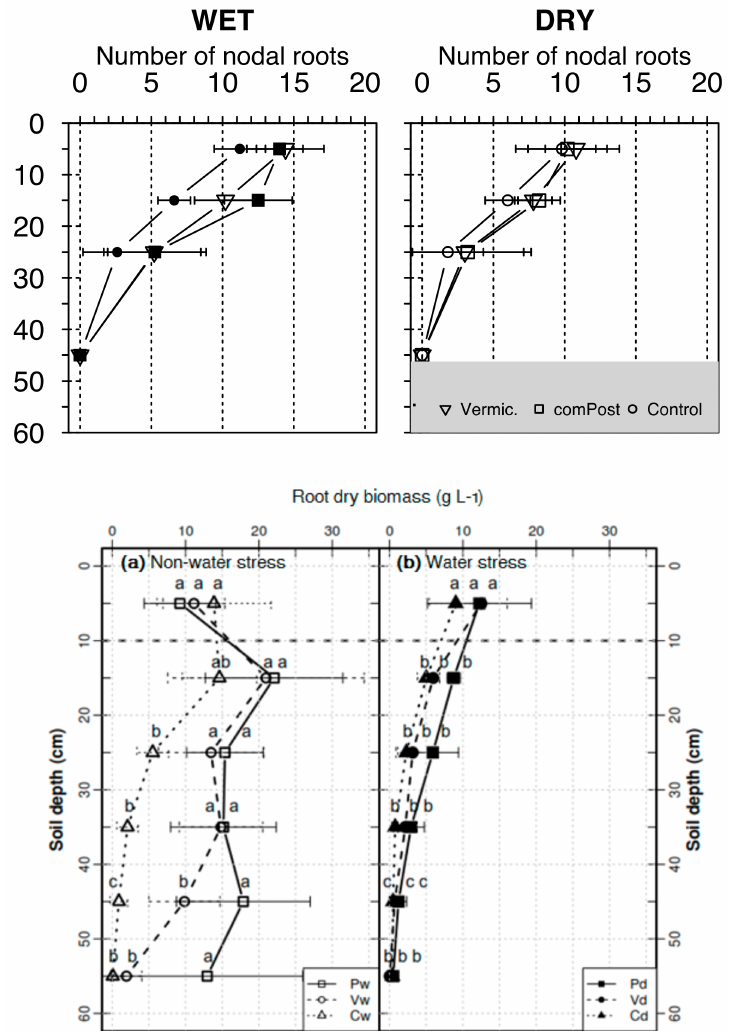
Figure 4. Number of nodal roots ( up ) and dry biomass (g L − 1 ) of fine roots ( bottom ) measured at four depths, the days following the plant harvesting. Error bars represent the standard deviation ( n = 5); different letters (along horizontal direction) indicate statistically significant differences ( p < 0.05) between